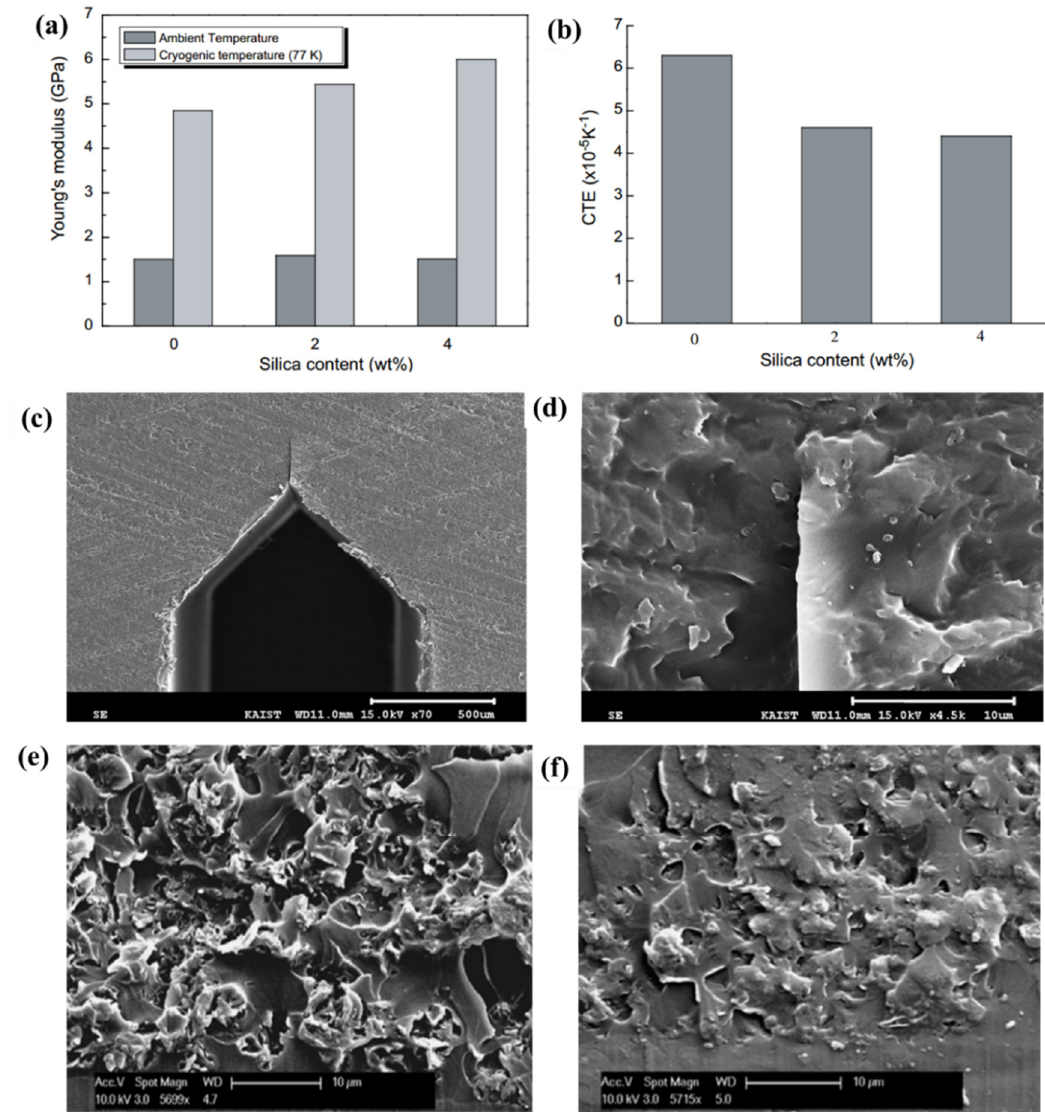
Figure 6. ( a )The effect of silica content on Young’s modulus of modified polymer composites and ( b ) the average CTE of modified polymer composites from 298 K to 77 K. Reused with permission from Ref. [45]. Copyright 2018 Elsevier. ( c ) the single edge notch bend specimen with a very sharp pre-crack, ( d ) magnified crack tip, fracture surfaces of the specimens tested nanoclay reinforced epoxy at ( e ) 273 Kand ( f ) 123 K. Reused with permission from Ref. [83]. Copyright 2008 Elsevier.